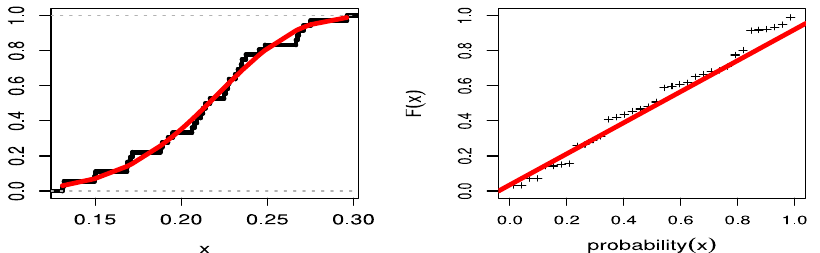
Figure 8. The CDF plot with empirical line and PP plot for Saudi Arabia data set.